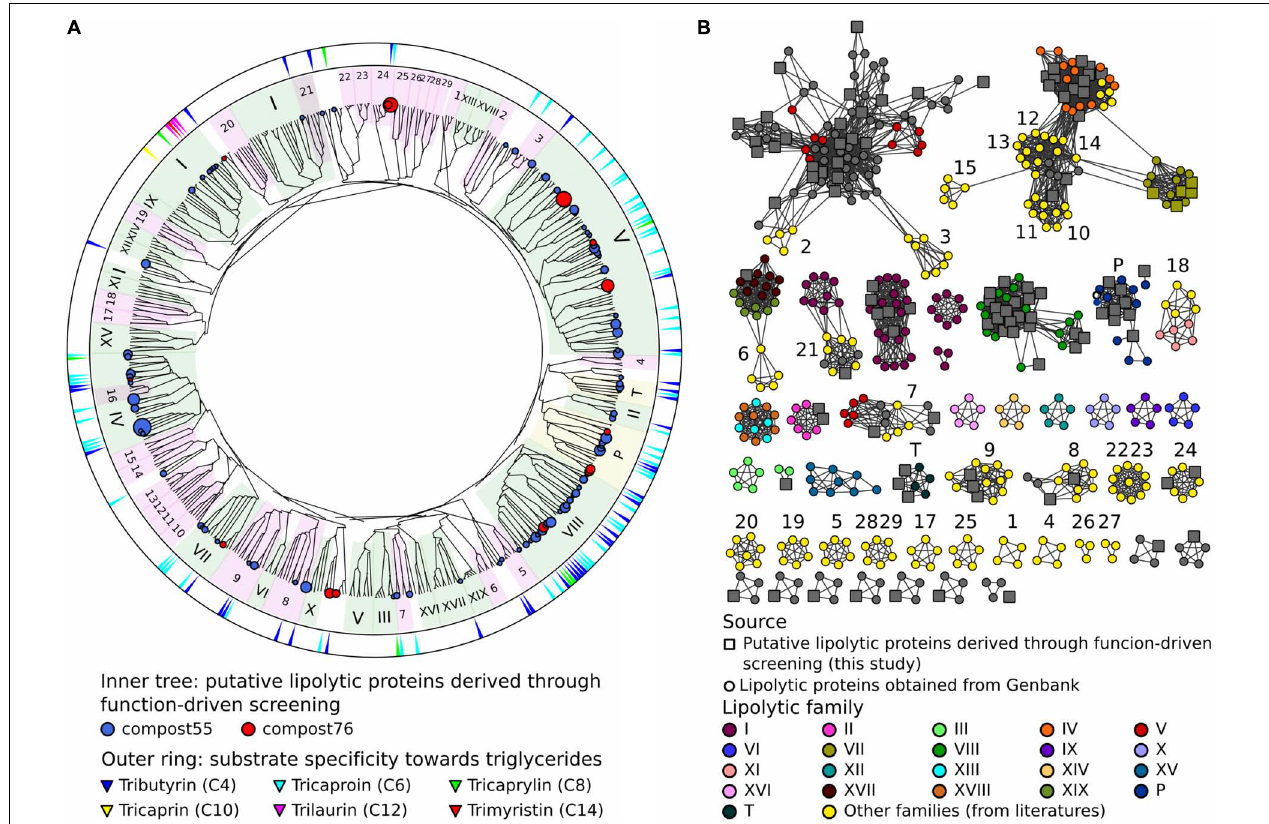
FIGURE 1 | Classification of LEs identified through the function-driven approach. (A) Scheme of a phylogenetic tree. The unrooted phylogenetic tree was constructed using FA-identified LEs in this study obtained and references retrieved from GenBank ( Supplementary Table 2 ). Phylogenetic tree was constructed using MEGA 7 with neighbor-joining method. The robustness of the tree was tested by bootstrap analysis with 500 replications. Inner tree: the circles represent LEs detected in compost55 (blue) and compost76 (red), sized by abundance (counts of replicates). LEs assigned to families of I-XIX were shaded in green background. Patatin-like-proteins and tannases (designated as P and T, respectively) were shaded in yellow. Other recent reported lipolytic families were shaded in magenta: 1, Est22 (Li et al., 2017); 2, EstL28 (Seo et al., 2014); 3, Rv0045c (Guo et al., 2010); 4, EstGX1 (Jiménez et al., 2012); 5, EstLiu (Rahman et al., 2016); 6, EstY (Wu and Sun, 2009); 7, EstGS (Nacke et al., 2011); 8, EM3L4 (Jeon et al., 2011b); 9, FLS18 (Hu Y. et al., 2010); 10, Est903 (Jia et al., 2019); 11, EstJ (Choi et al., 2013); 12, PE10 (Jiang et al., 2012); 13, Est12 (Wu et al., 2013); 14, EstDZ2 (Zarafeta et al., 2016); 15, Est9x (Jeon et al., 2009); 16, Lip10 (Guo et al., 2016); 17, EstGH (Nacke et al., 2011); 18, EML1 (Jeon et al., 2009); 19, FnL (Yu et al., 2010); 20, EstP2K (Ouyang et al., 2013); 21, LipA (Couto et al., 2010); 22, LipSM54 (Li et al., 2016); 23, MtEst45 (Lee, 2016); 24, LipT (Chow et al., 2012); 25, EstSt7 (Wei et al., 2013); 26, Rlip1 (Liu et al., 2009); 27, EstA (Chu et al., 2008); 28, FLS12 (Hu Y. et al., 2010); 29, lp_3505 (Esteban-Torres et al., 2014). Outer ring: substrate specificity of corresponding clones toward different carbon chain length (C4–C14) of triglycerides. (B) Protein sequence similarity network of LEs belonging to different families. Networks were generated from all-by-all BLAST comparisons of amino acid sequences from the same dataset used for the construction of the phylogenetic tree. Each node represents a sequence. Larger square nodes represent LEs derived from function-based screening performed in this study. Small circle nodes represent LEs retrieved from GenBank. Nodes were arranged using the yFiles organic layout provided in Cytoscape version 3.4.0. Each edge in the network represents a BLAST connection with an E -value cutoff of ≤ 1e − 16 . At this cut-off, sequences have a mean percent identity and alignment length of 36.3% and 273 amino acids, respectively.